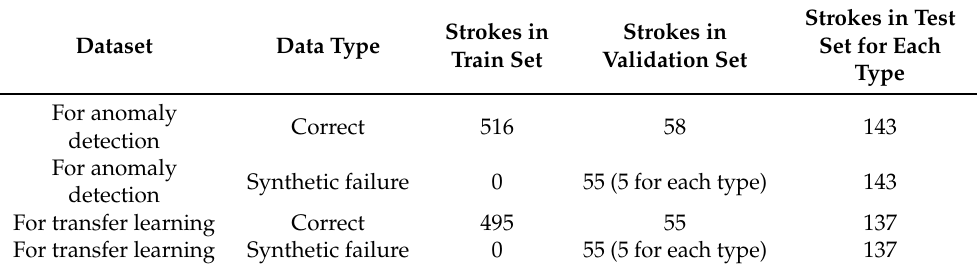
Table 2. Number of strokes available for training, validation and testing in anomaly detection and adaptability experiments. The indication “for each type” refers to each of the synthetic failure types and their magnitude combinations, which consists of 11 types.